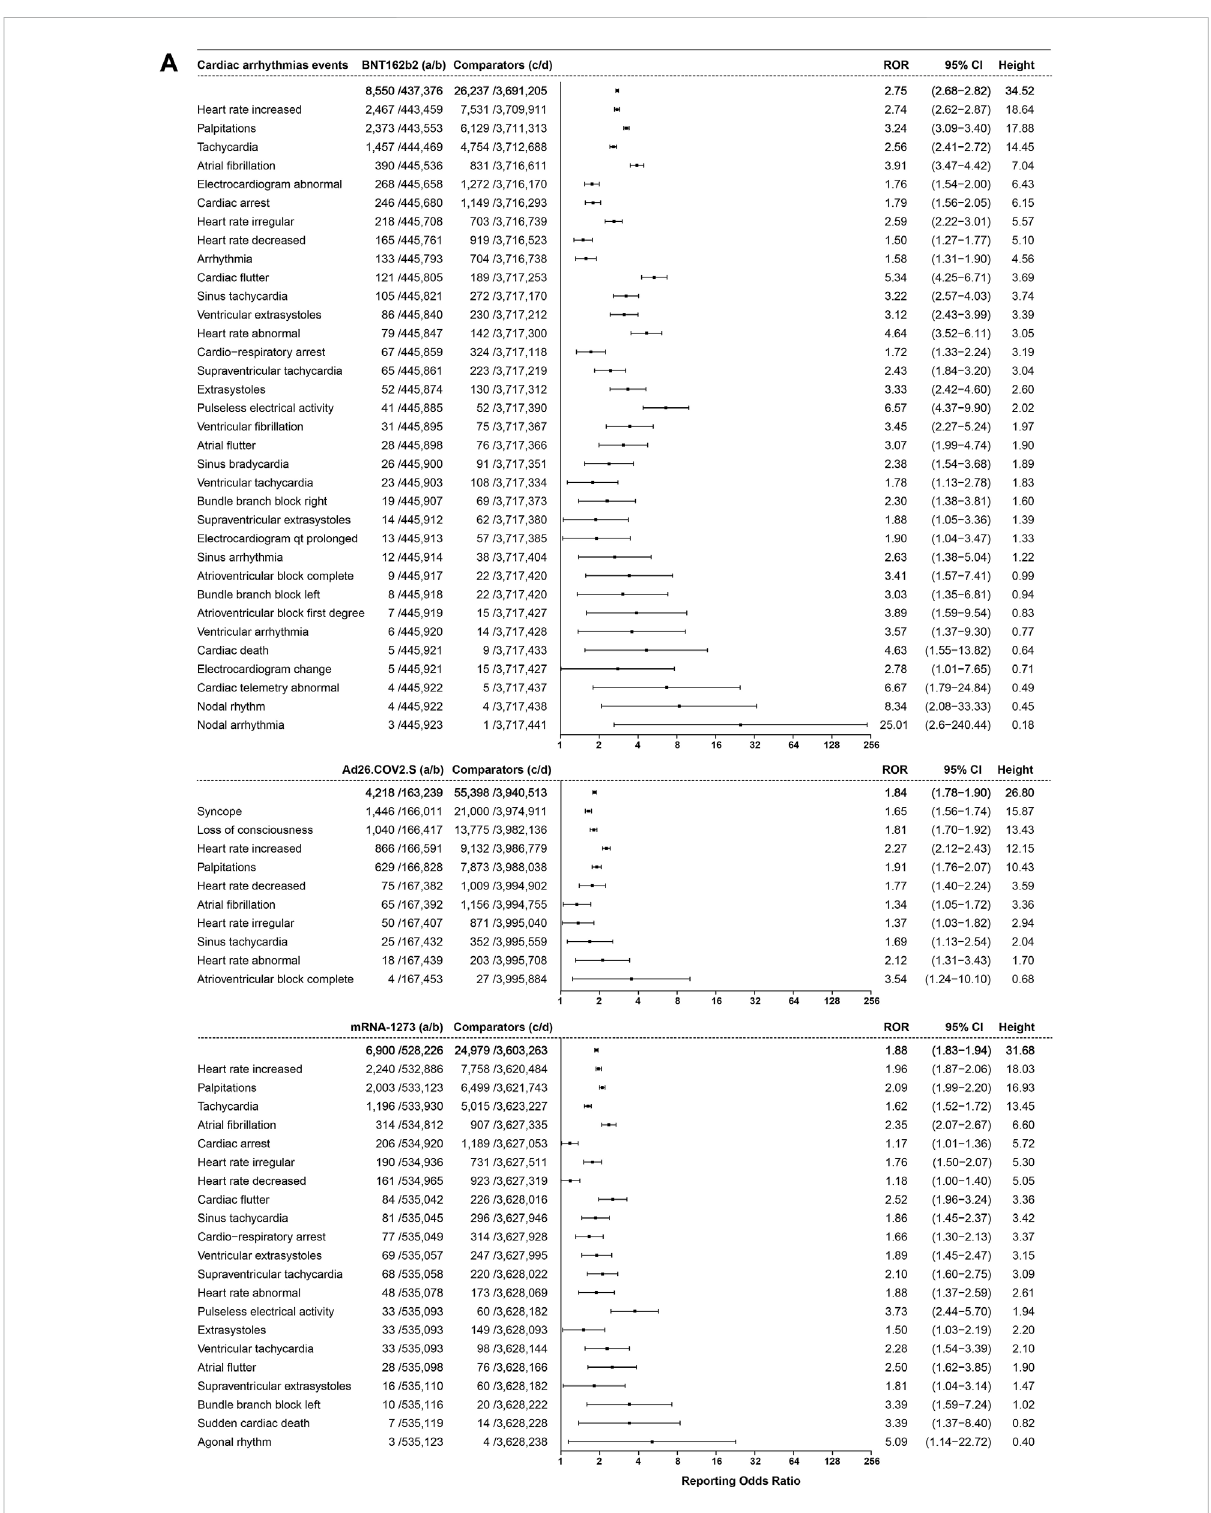
FIGURE 6 (A) ROR values and height of the COVID-19 vaccines of BNT162b2-, Ad26.COV2.S-, and mRNA-1273-associated cardiac arrhythmia events. a: cases of target cardiac arrhythmia events reported concerning thetarget COVID-19 vaccines; b: cases of other adverse events reported concerning the target COVID-19 vaccines; c: cases of target cardiac arrhythmia events reported concerning all the other vaccines; d: cases of other adverse events reported concerning all the other